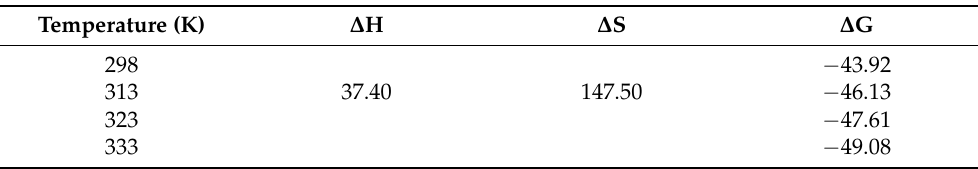
Table 3. Calculated values of adsorption thermodynamic parameters indicating the adsorption of MO was a spontaneous and endothermic